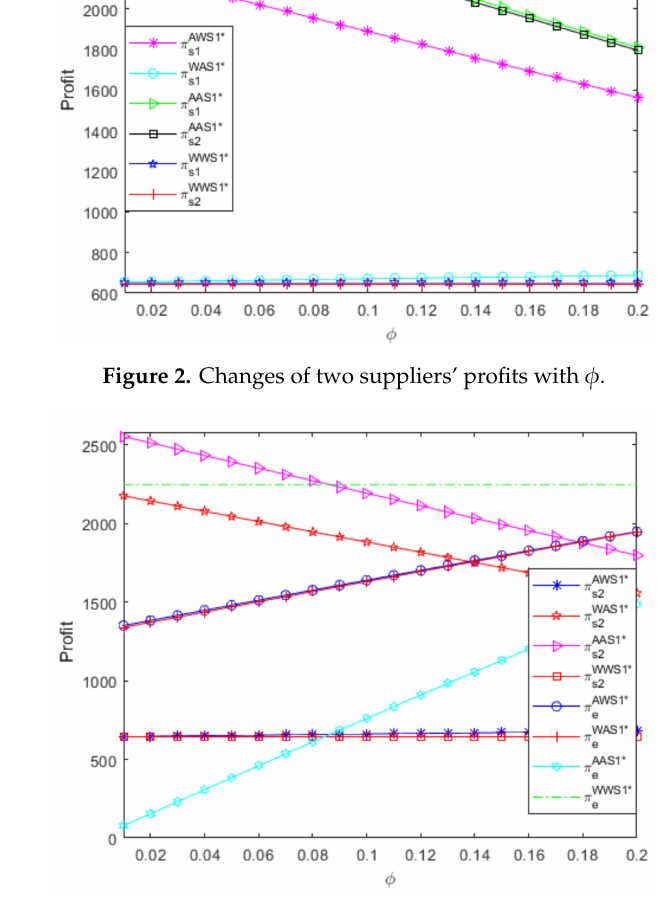
Figure 3. Changes of supplier 2’s and e-retailer’s profits with φ